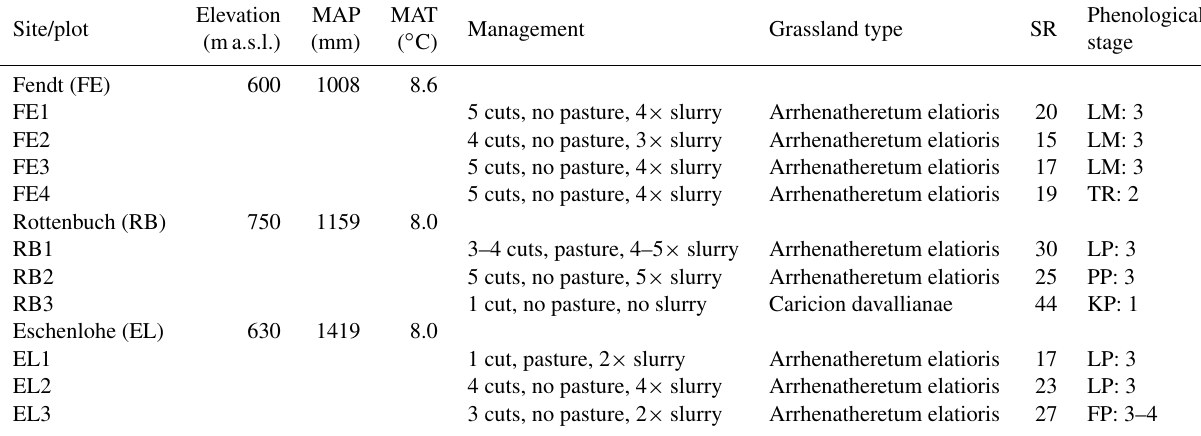
Table 2. Details about the two multispectral sensors used in this study. n/a: not applicable.